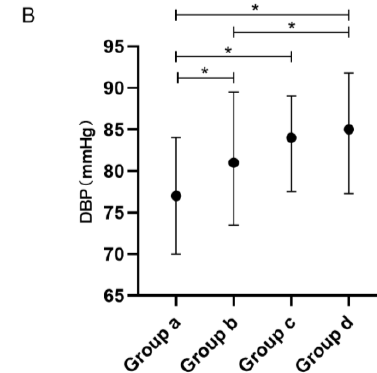
Figure 2. Blood pressure levels stratified by obesity and severe OSA. Footnote: Group a, non-obese with non-severe OSA group; Group b, non-obese with severe OSA group; Group c, obese with non-severe OSA group; Group d, obese with severe OSA group; subfigure ( A ), comparison of SBP level among the four gruops; subfigure ( B ), comparison of DBP level among the four groups; *, p < 0.05. Abbreviations: OSA, obstructive sleep apnea; SBP, systolic blood pressure; DBP, diastolic blood pressure.